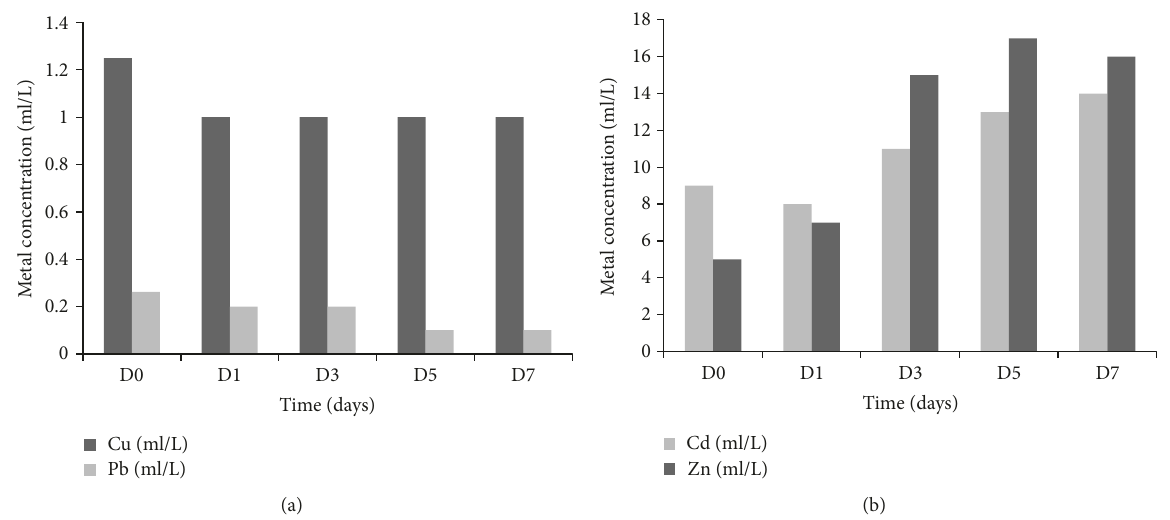
Figure 7: (a) Concentrations of Cu and Pb in phytoremediation systems with Typha latifolia [52]. (b) Concentration of Zn and Cd in Typha latifolia